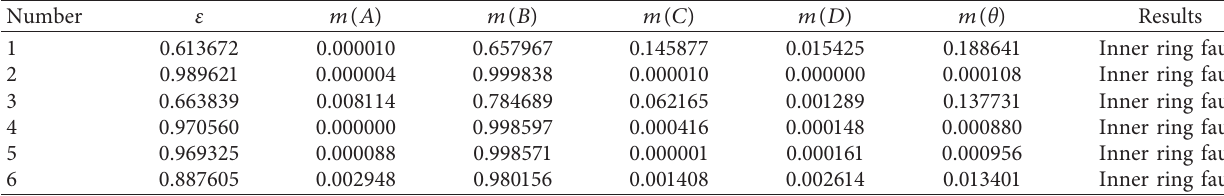
Table 8: The result of the convergence of three